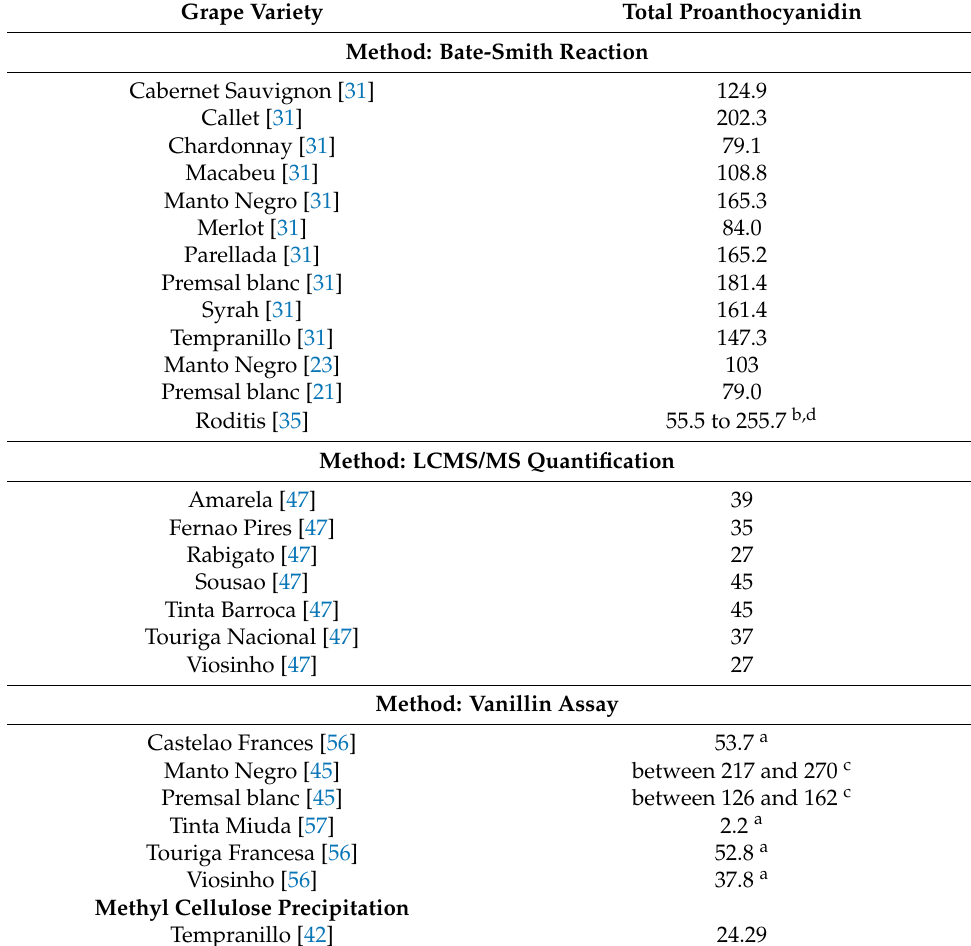
Table 8. Total proanthocyanidin content of grape stem extracts (mg/g DM).